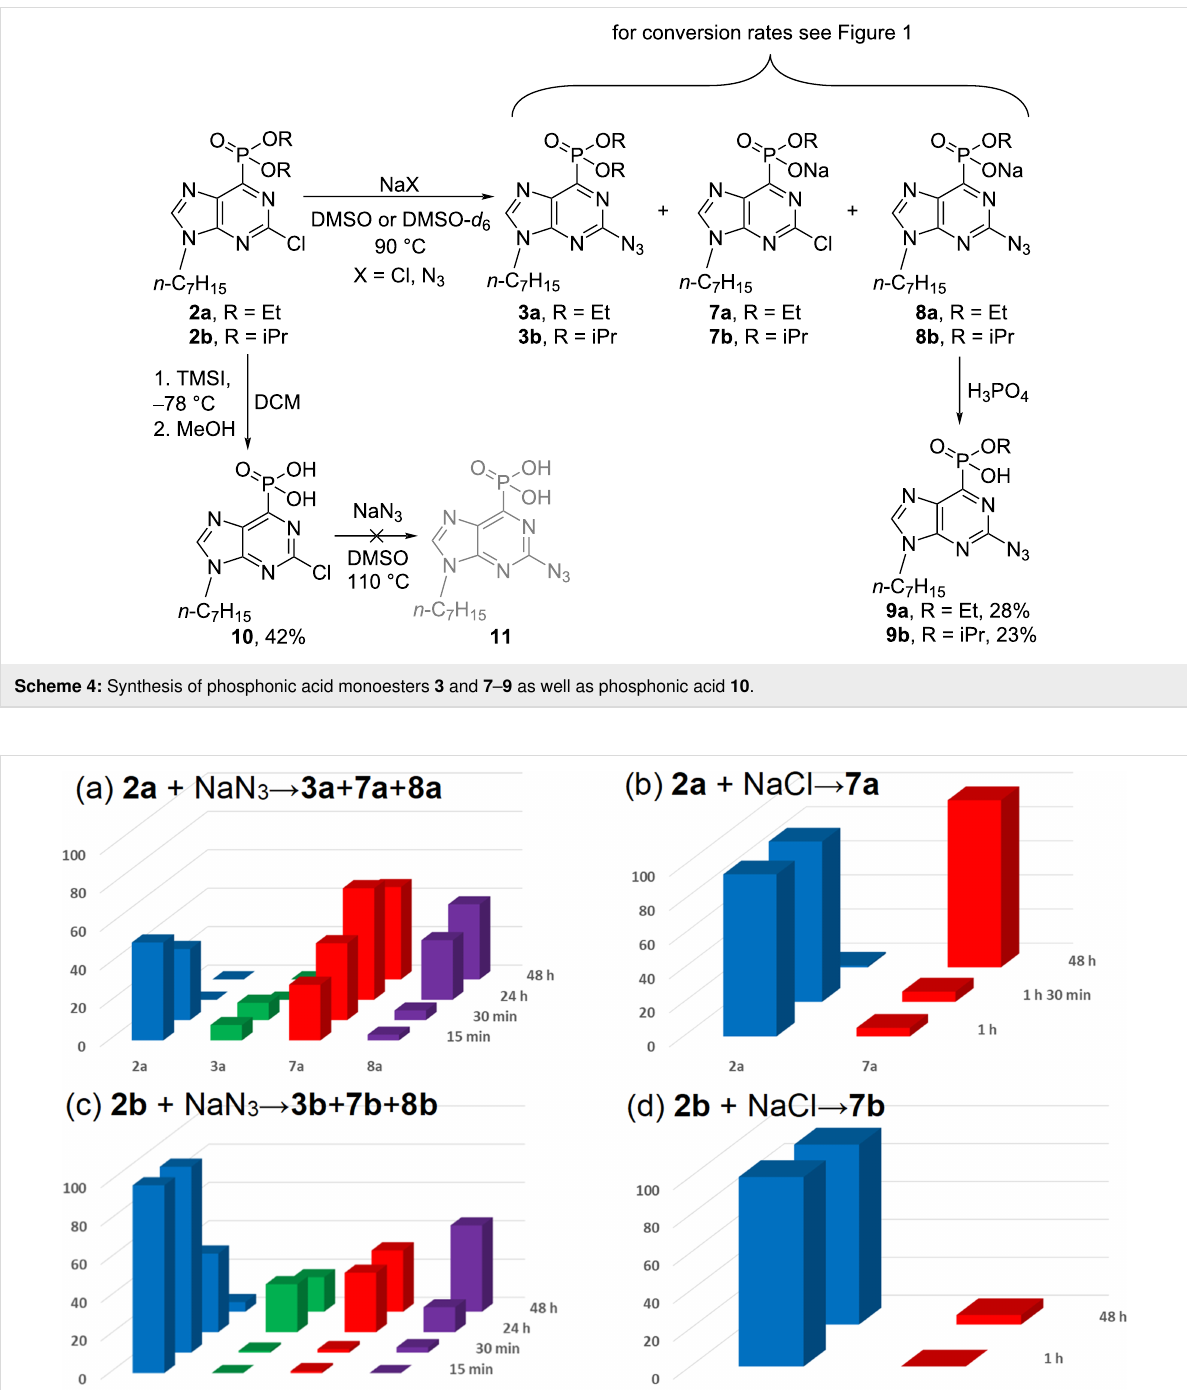
more, the hydrolysis of the dialkyl ester groups were performed with TMSI [29,30], and phosphonic acid 10 was obtained. The latter was inert to the S N Ar reaction with NaN 3 at C2 (Scheme